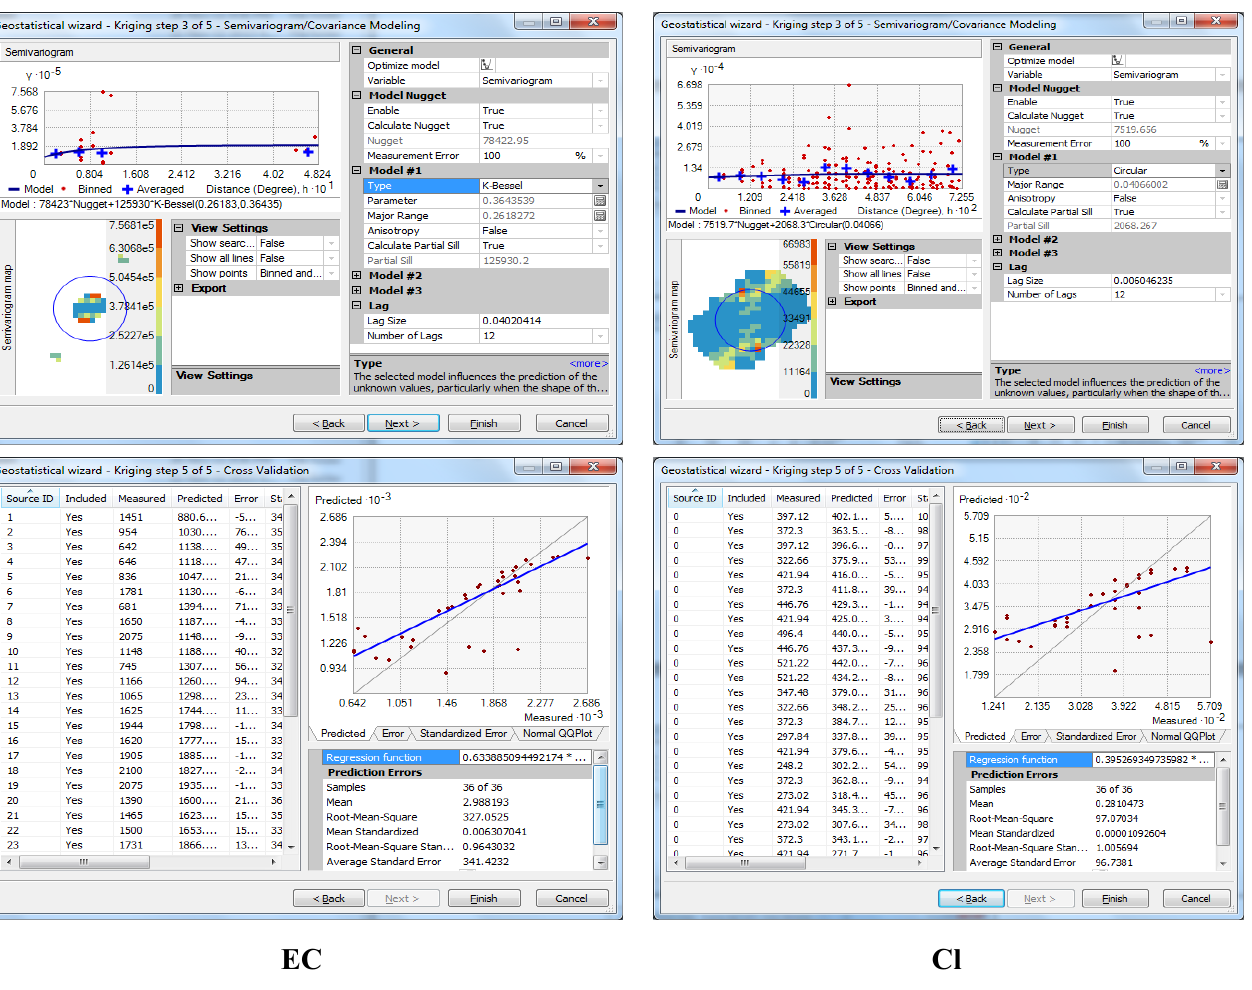
Figure 3. Cross validation and semivariograms model for EC and Cl